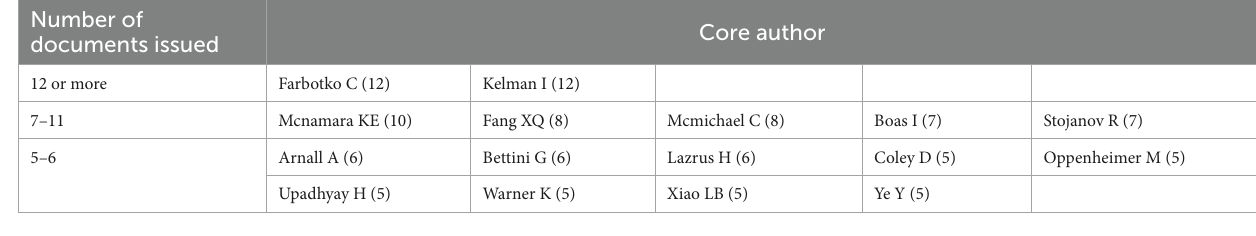
TABLE 4 Statistics of more than two core authors (CNKI